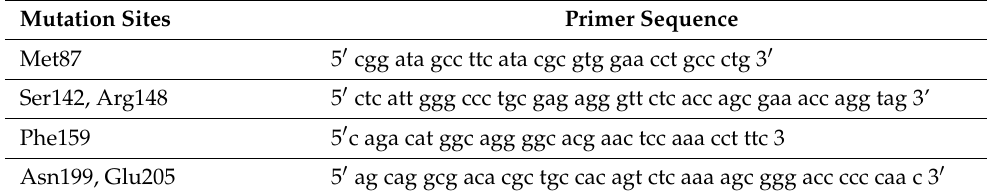
Table 4. Primer sequences used in the PCR